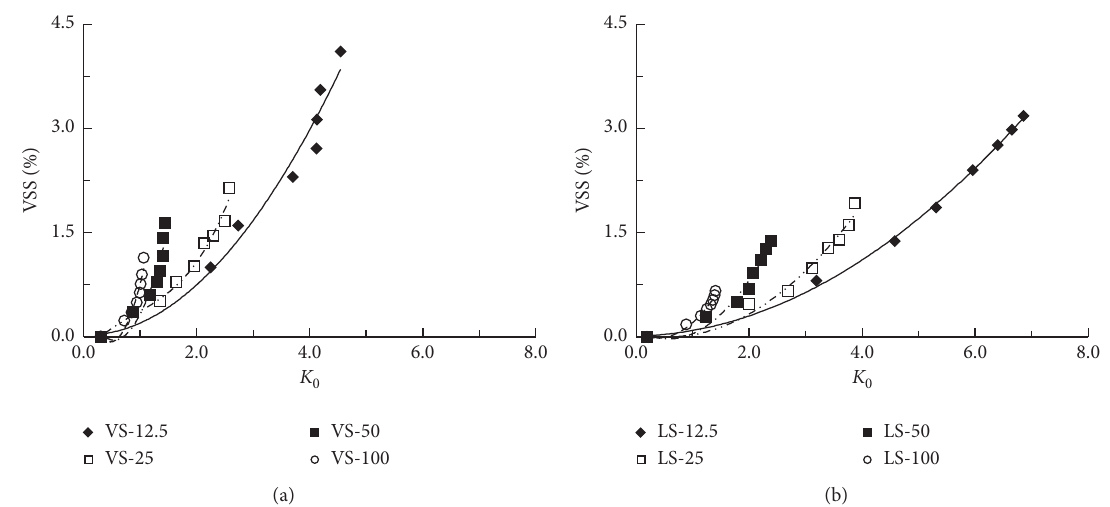
Figure 10: Variation of VSS under different matric suction with net stress ratio K